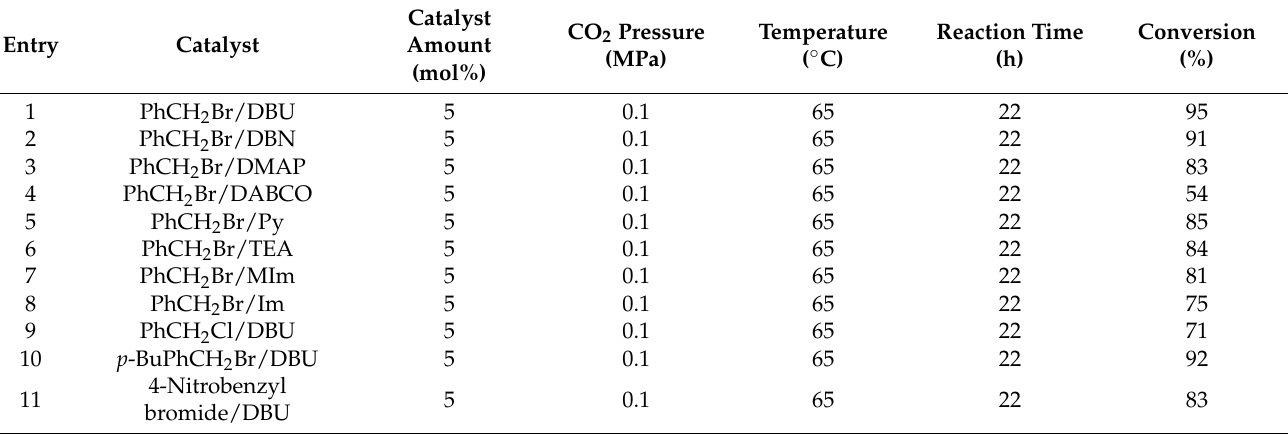
Table 16. The effect of organic bases on cycloaddition (compared with DBU in co-action with alkyl halides)